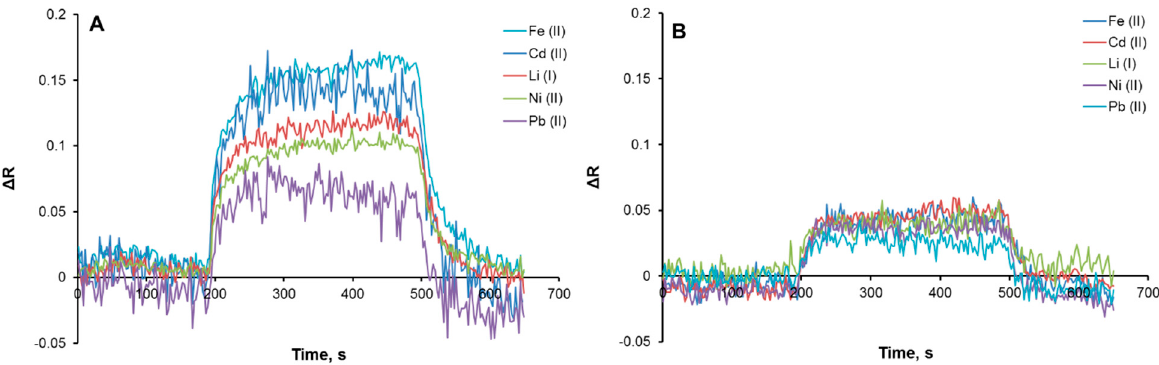
Figure 5. Selectivity performance of Cu(II)-imprinted ( A ) and non-imprinted ( B ) plasmonic sensors.